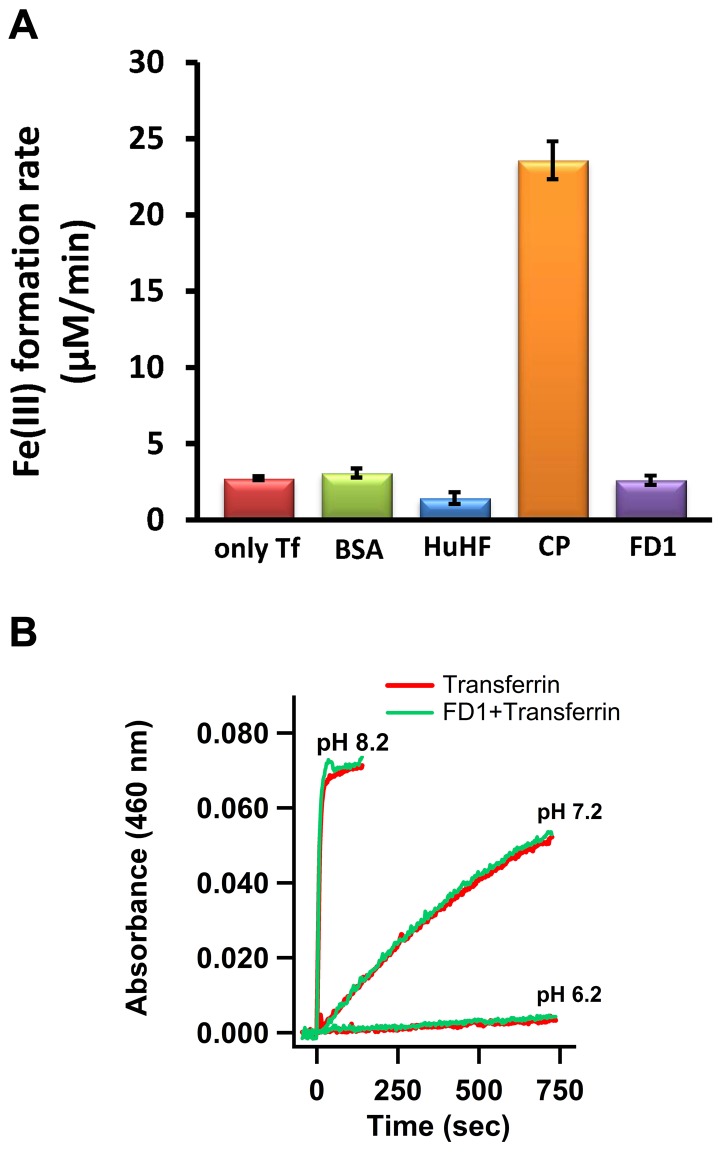
The FD1 peptide does not catalytically oxidize iron as measured by the transferrin assay.(A) Non-enzymatic oxidation of Fe(II) and incorporation of Fe(III) into transferrin was compared with that of BSA, HuHF, ceruloplasmin (CP) and FD1. 52 µM of apo-transferrin was mixed with 2 µM BSA or 0.18 µM HuHF (24-mer) or 2 µM FD1 peptide, or 0.1 µM ceruloplasmin, and then an aliquot of 5 µl anaerobic solution of ferrous sulphate was added. Measurements were done in 100 mM Hepes, 100 mM NaCl, pH 7.2. Final concentration of Fe(II) was 40 µM. (B) Effect of pH on non-enzymatic oxidation of Fe(II) in the presence of transferrin was checked at three different pH values in the presence or absence of FD1 peptide (2 µM): pH 6.2, 100 mM Mes, 100 mM NaCl; pH 7.2, 100 mM Hepes, 100 mM NaCl, and pH 8.2, 100 mM Tris, 100 mM NaCl. Concentration of apo-transferrin was 52 µM. Final concentration of Fe(II) was 40 µM. Measurements were performed at 37°C in triplicate with two different batches of transferrin.